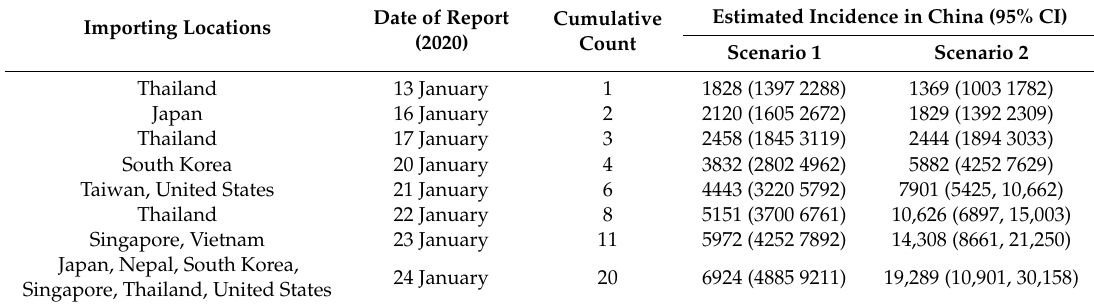
Figure 2. Cumulative incidence and the confirmed case fatality risk of the novel coronavirus (COVID-19) outbreak in China, 2020. ( A , B ) Observed and estimated cumulative number of cases in China by the date of report. An exponential growth curve was extrapolated using the exported case data. Scenario 1 extrapolated the exponential growth from December to first case on 8 December 2019, while Scenario 2 started the estimation of the exponential growth only from 13 January 2020. The black line and shaded area represent median and 95% credible interval of the cumulative incidence in China, respectively. The blue bars show the cumulative number of reported cases from the government of mainland China. The cumulative number of reported cases was not used for fitting, but it was shown for comparison between the cumulative number of reported and estimated cases in China. There is a decrease in the cumulative number of reported cases in early January, because only 41 cases tested positive for the novel coronavirus among the reported 59 cases on 10 January 2020. Left-top panels on both A and B show the cumulative numbers of exported cases observed in other countries and the cumulative number of deaths in China, represented by dark and light green bars, respectively. ( C , D ) Confirmed case fatality risk (cCFR) by the date of reporting. Each value of cCFR was estimated as the ratio of cumulative number of estimated incidence to death at time t . The points and error bars represent the median and its 95% credible interval of the cCFR. All 95% credible intervals were derived from Markov chain Monte Carlo simulations. Table 1. Exportation events and estimated incidence in China,